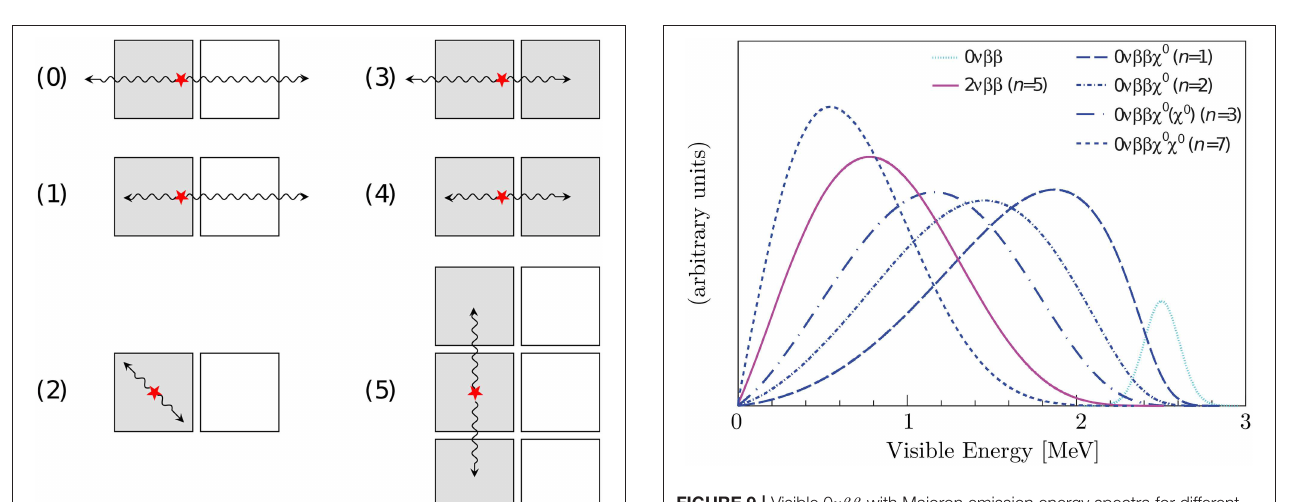
FIGURE 9 | Visible 0 νββ with Majoron emission energy spectra for different spectral index n in the case of 136 Xe. The line at Q ββ , charaterized by the KamLAND-Zen detector resolution, indicates the position of the 0 νββ peak without Majoron emission. Figure from Gando et al. [106], with permission from the American Physical